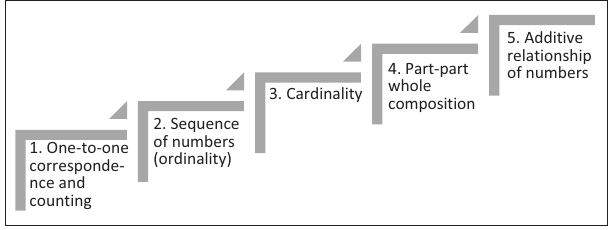
FIGURE 1: A conceptual model for early numerical